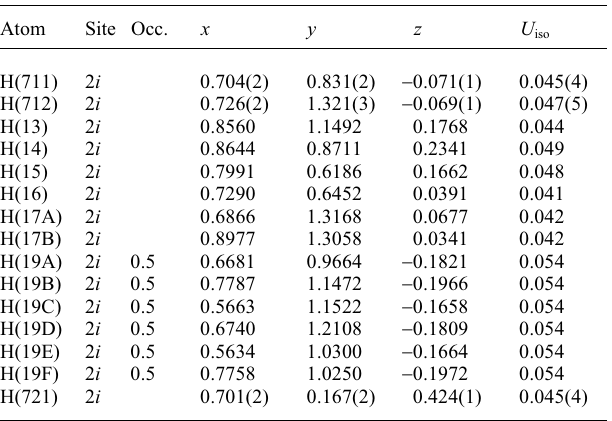
Table 2. Atomic coordinates and displacement parameters (in Å 2 ) .